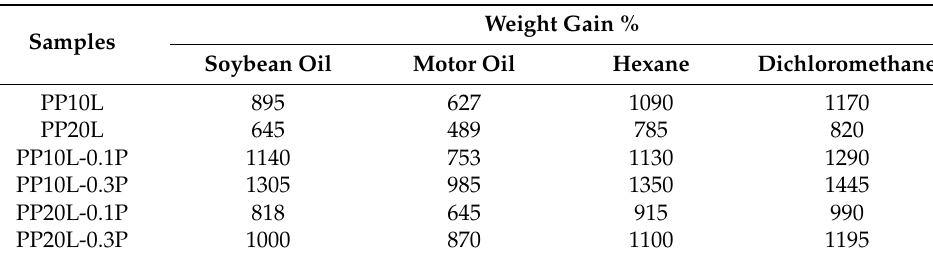
Table 6. Weight gain of sponges with tested liquid (soybean oil, motor oil, hexane, and dichloro- methane).